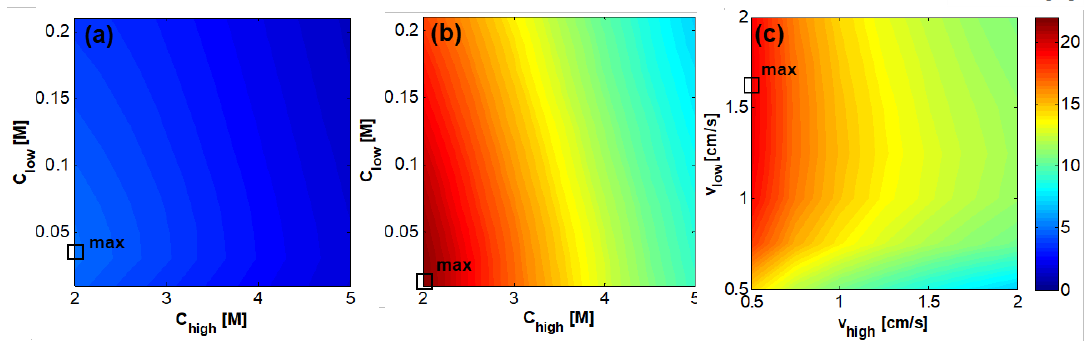
Figure 8. Effect of the feeds inlet concentration on Yield [%] for the case of RED stack with 50 cell pairs, v H = v L = 1 cm/s, counter-current arrangement, and membrane area of ( a ) 0.1 × 0.1 m 2 and ( b ) 0.1 × 0.88 m 2 ; ( c ) Effect of feeds inlet velocity for the case of RED stack with 50 cell pairs, C H = 4.5 M and C L = 0.01 M, counter-current arrangement, and membrane area of 0.1 × 0.88 m 2 . RED Performance with Ideal